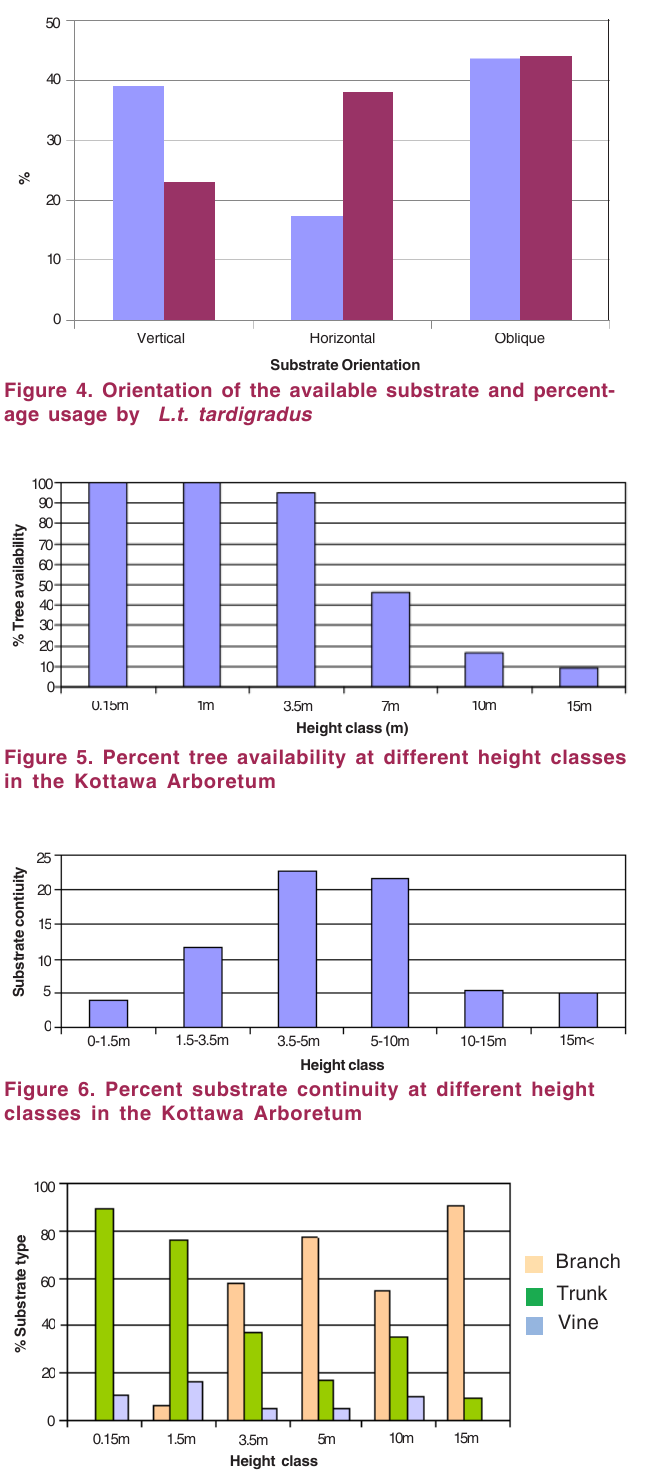
Figure 7. Percentage availability of different substrate types at the different heights of the vertical axis at Kottawa